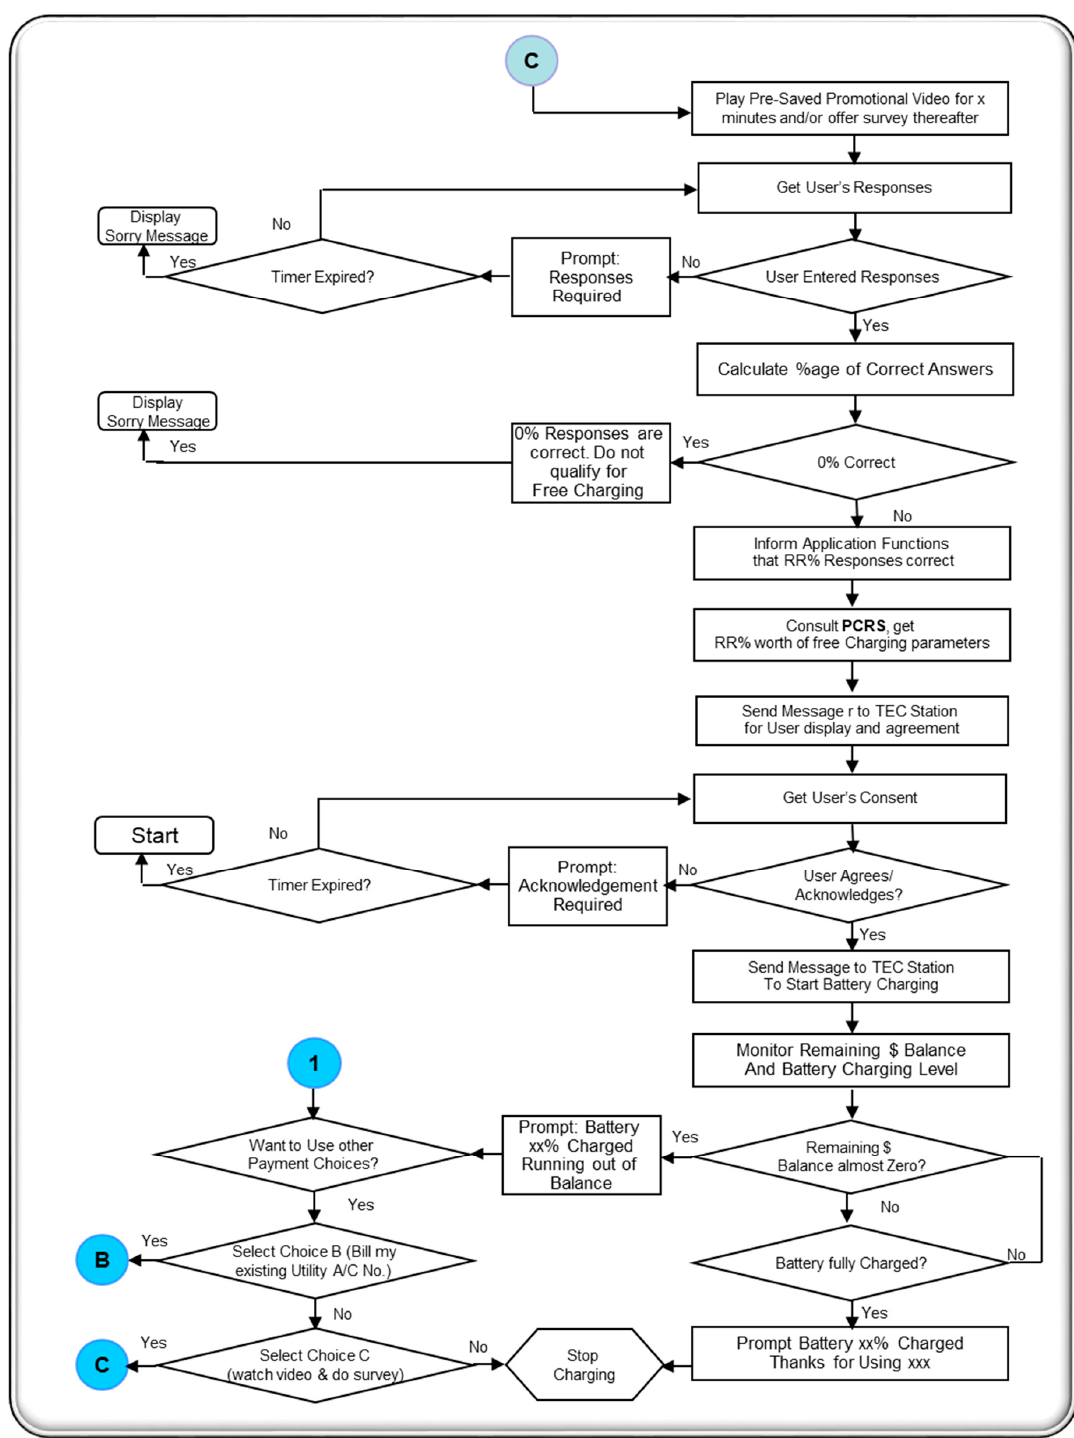
Figure 5. Toll-free service provisioning Type-1 (promotional charging service).